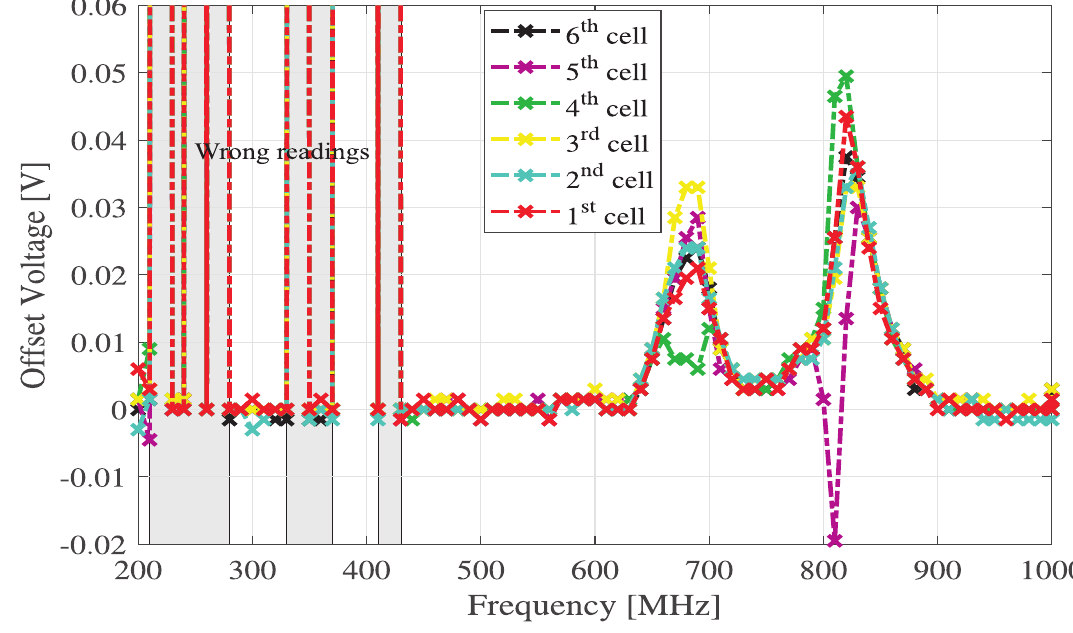
Figure 13. EMI-induced offset in the cell voltage readings. Antenna in front of the EUT (Figure 12). Vertical